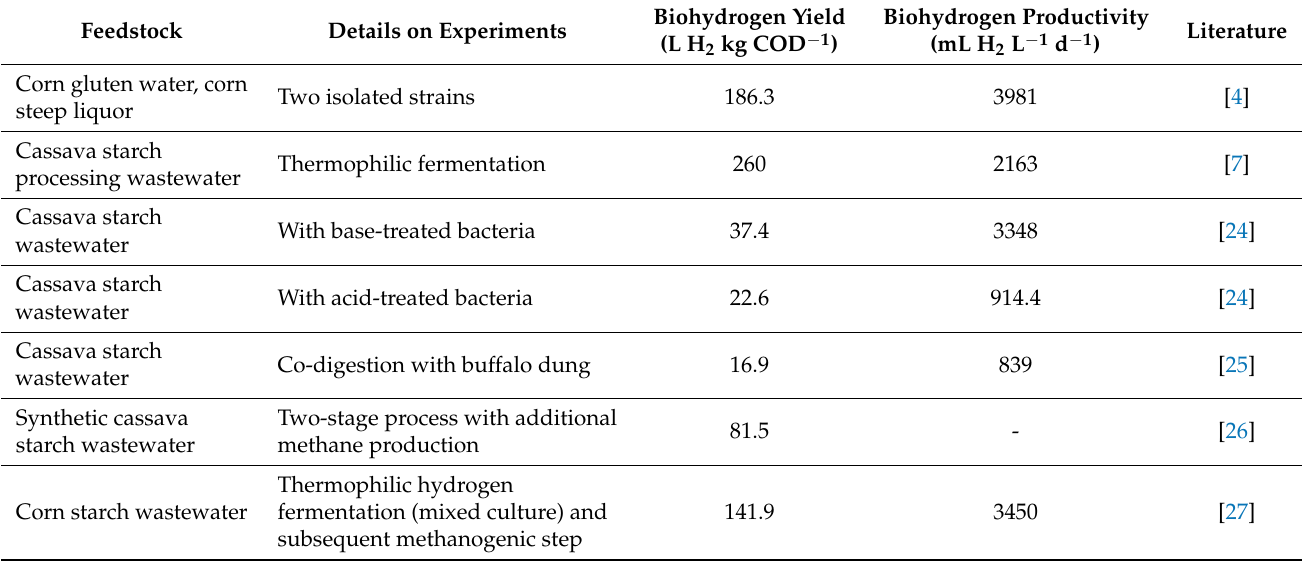
Table 2. Biohydrogen yields and productivity from different starch wastewaters and under varying experimental conditions.